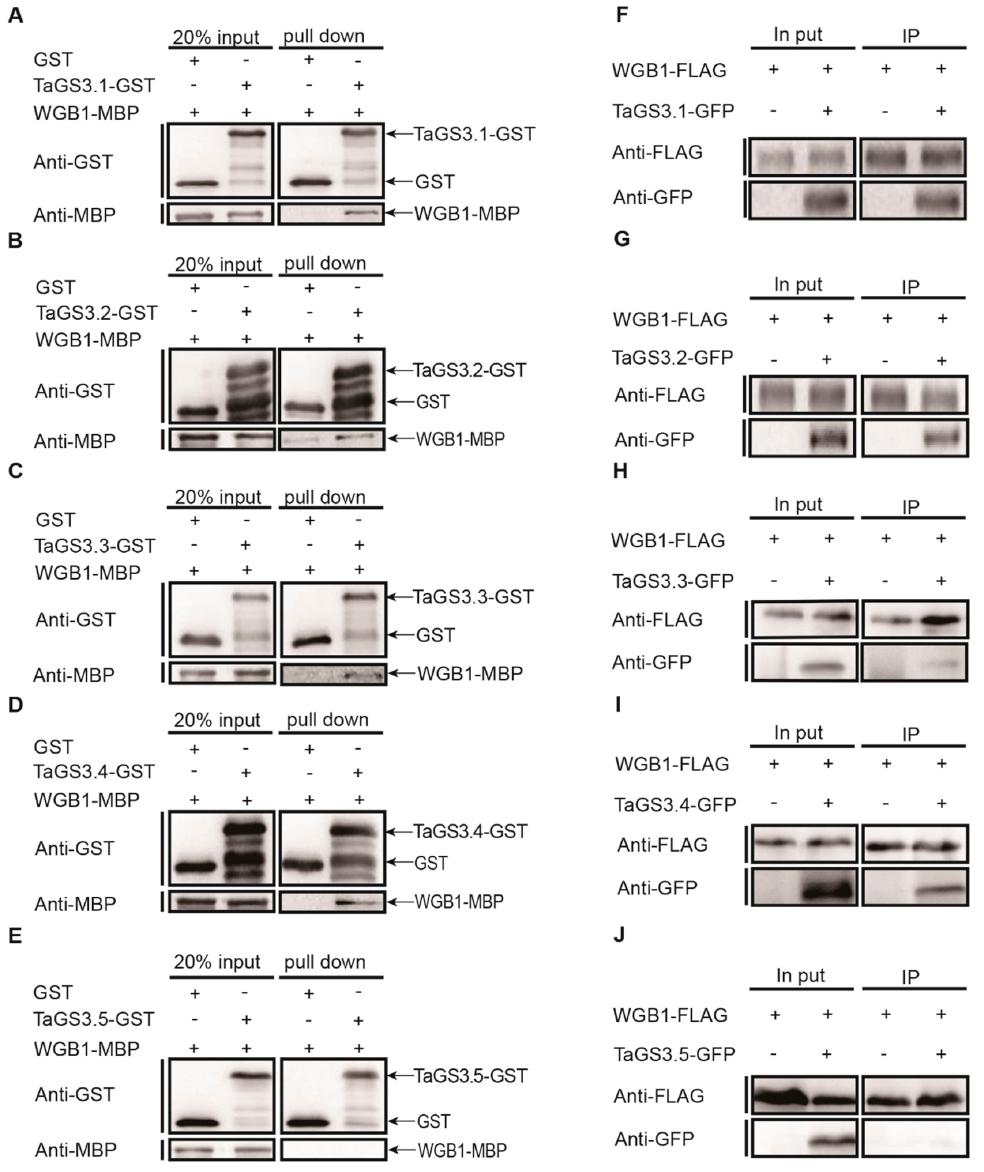
Figure 6. Interaction analyses of TaGS3 isoforms with WGB1. ( A – E ) In vitro GST pull-down assays showing the interactions between TaGS3 isoforms and WGB1. Recombinant maltose binding protein WGB1-MBP and five TaGS3 isoforms-GST were used. ( F – J ) In vivo Co-IP assays showing the interactions between TaGS3 isoforms and WGB1. FLAG-tagged WGB1 was co-expressed with GFP-tagged TaGS3 isoforms in N. benthamiana leaves.